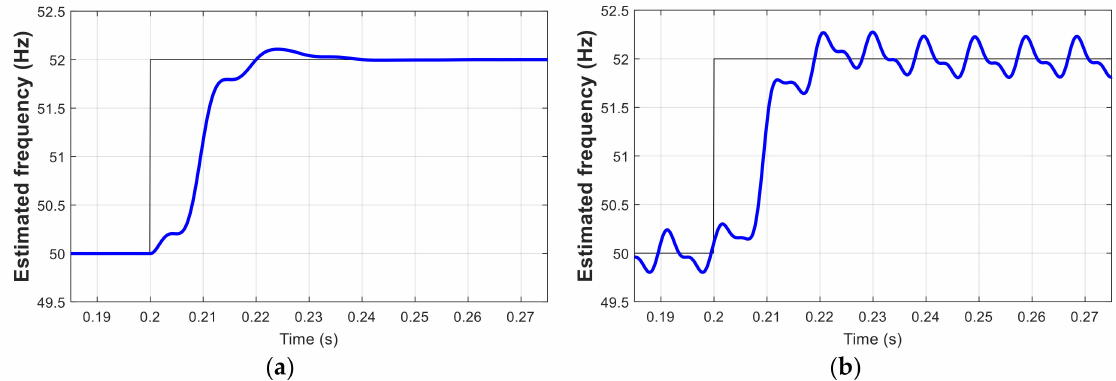
Figure 9. Transient responses of the SOGI-FLL-EbA to a frequency step perturbation of 2 Hz. ( a ) without harmonic distortion. ( b ) with a 3rd harmonic and 3% voltage amplitude regarding